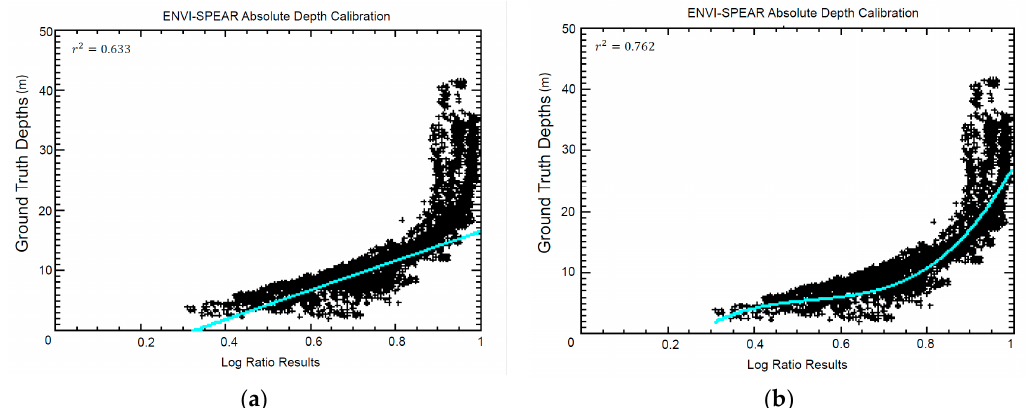
Figure 5. Absolute depth calibration plot calculated with ENVI-SPEAR tool with ( a ) linear model calibration and ( b ) polynomial curve model calibration.